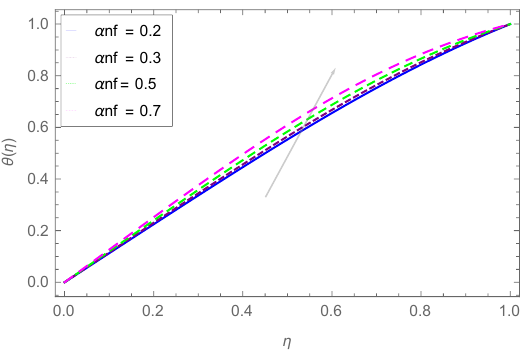
Figure 6. Plot displaying θ ( η ) dependence on α nf .